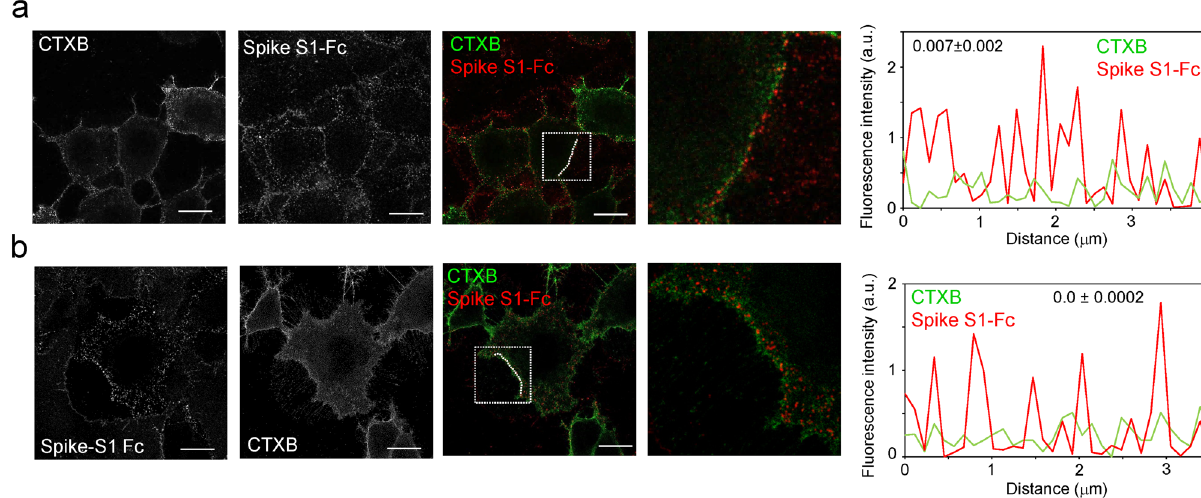
Figure 2. Detection of Spike S1 and cholera toxin-B binding sites in cells. Vero cells on glass coverslips were incubated in the cold with cholera toxin-B–Alexa555 (CTXB) for 10 min before ( a ) or after ( b ) incubation with Spike S1-Fc for 1 h followed by anti-human IgG-Alexa647 for another hour. Cells were extensively washed after each incubation. At the end of the procedure, cells were fixed and mounted for visualization by confocal microscopy. Images of individual channels and a merged image of a section at mid-cell height are shown. Regions of interest in the merged images, delimited by dotted squares, are magnified on the right. Graphs on the far right display the fluorescence intensity profiles of Spike S1-Fc (red) and CTXB (green) signals along the dotted lines marked in the merged images. Numbers in insets show the Manders’ colocalization coefficients for every condition, obtained applying the Costes’ threshold. Results are depicted as mean values ± SEM of 42 and 14 measurements for ( a , b ), respectively. Bars, 20